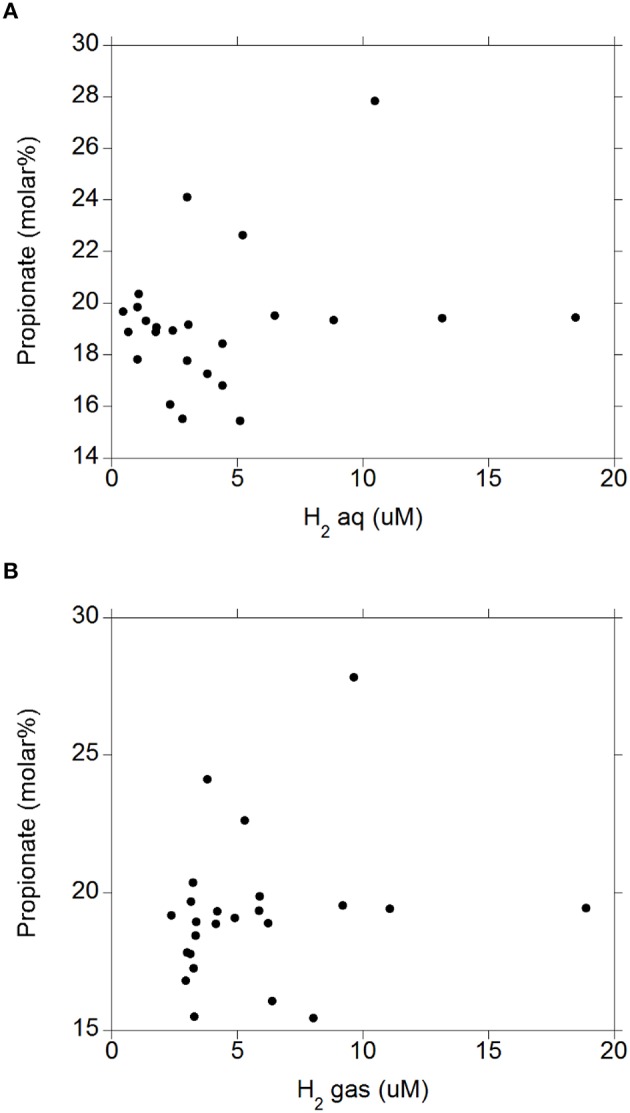
Relationship between propionate molar percentage and concentration of dissolved and gaseous H2. (A) propionate% = 18.6 (±0.78; P < 0.001) + 0.15 (±0.13; P = 0.24) H2 (aq); R2 = 0.062 (P = 0.24); (B) H2: propionate% = 18.4 (±1.01; P < 0.001) + 0.14 (±0.15; P = 0.36) H2 (g); R2 = 0.038 (P = 0.36).